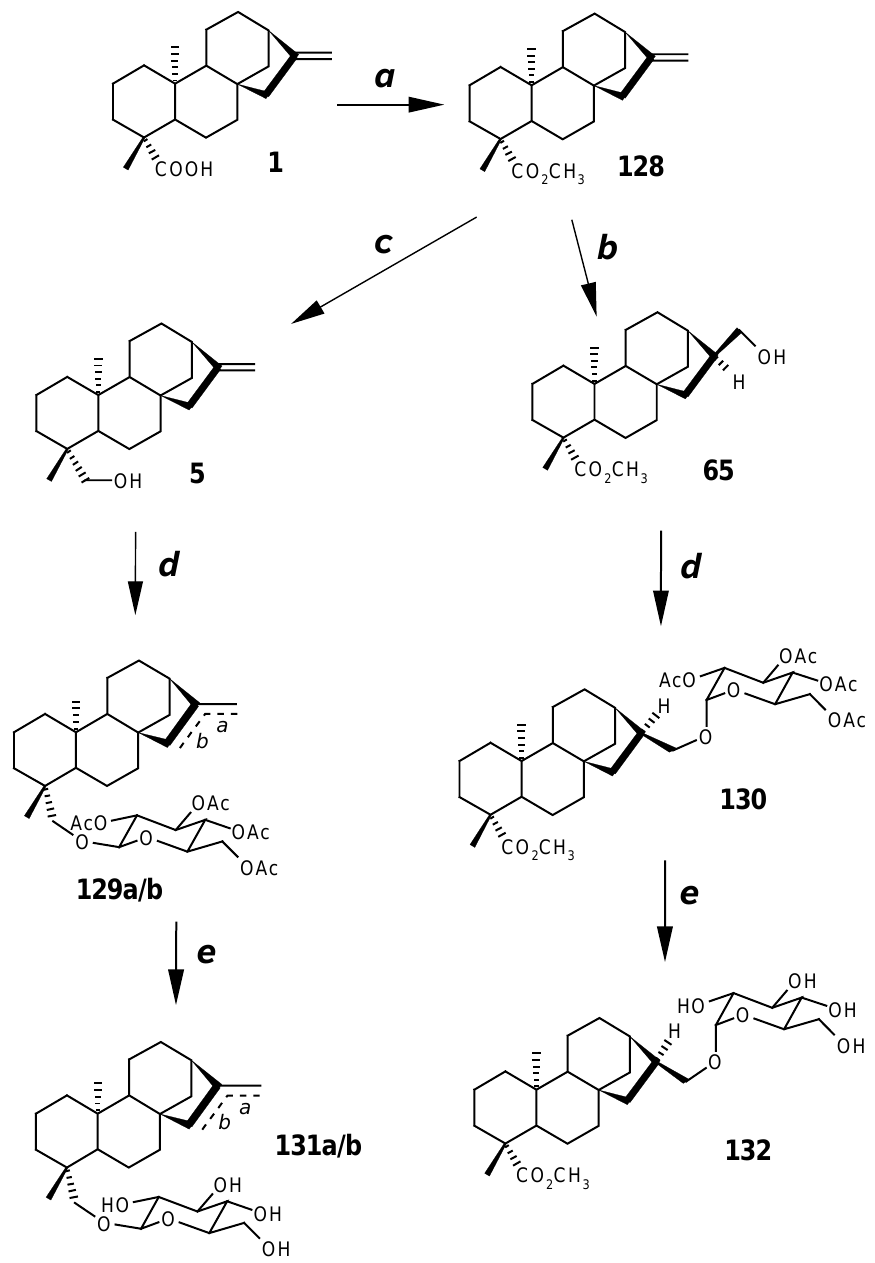
Scheme 3. Synthesis of kaurane glycosides from kaurenoic acid ( 1 )